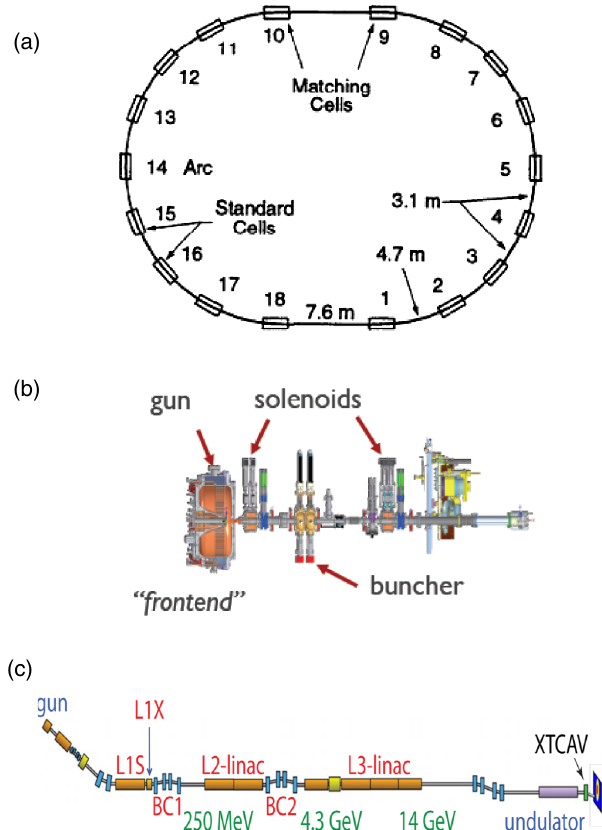
FIG. 1. Test cases for utilized in this investigation: (a) Sche- matic of the SPEAR3 storage ring, (b) the LCLS-II Injector frontend, and (c) the LCLS electron